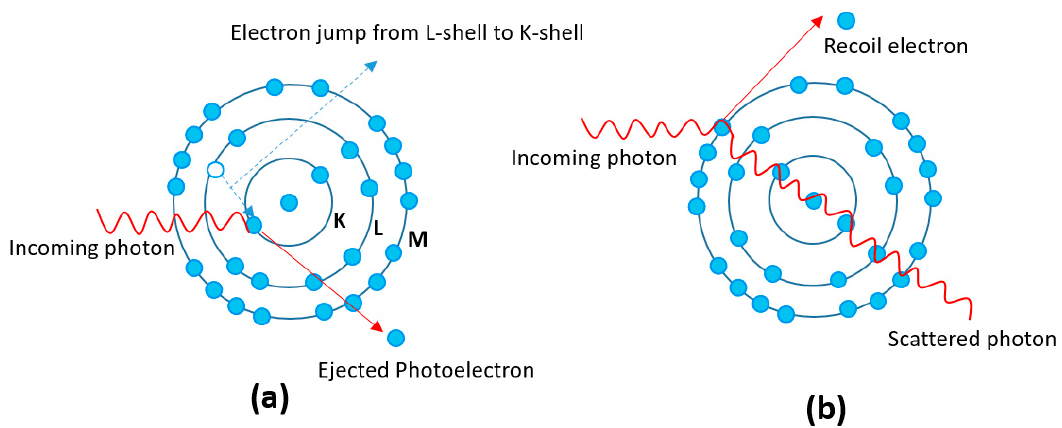
Figure 3. Interaction of X-ray photons to the subjected atom, showing: ( a ) photoelectric absorption; and ( b ) Compton scattering.